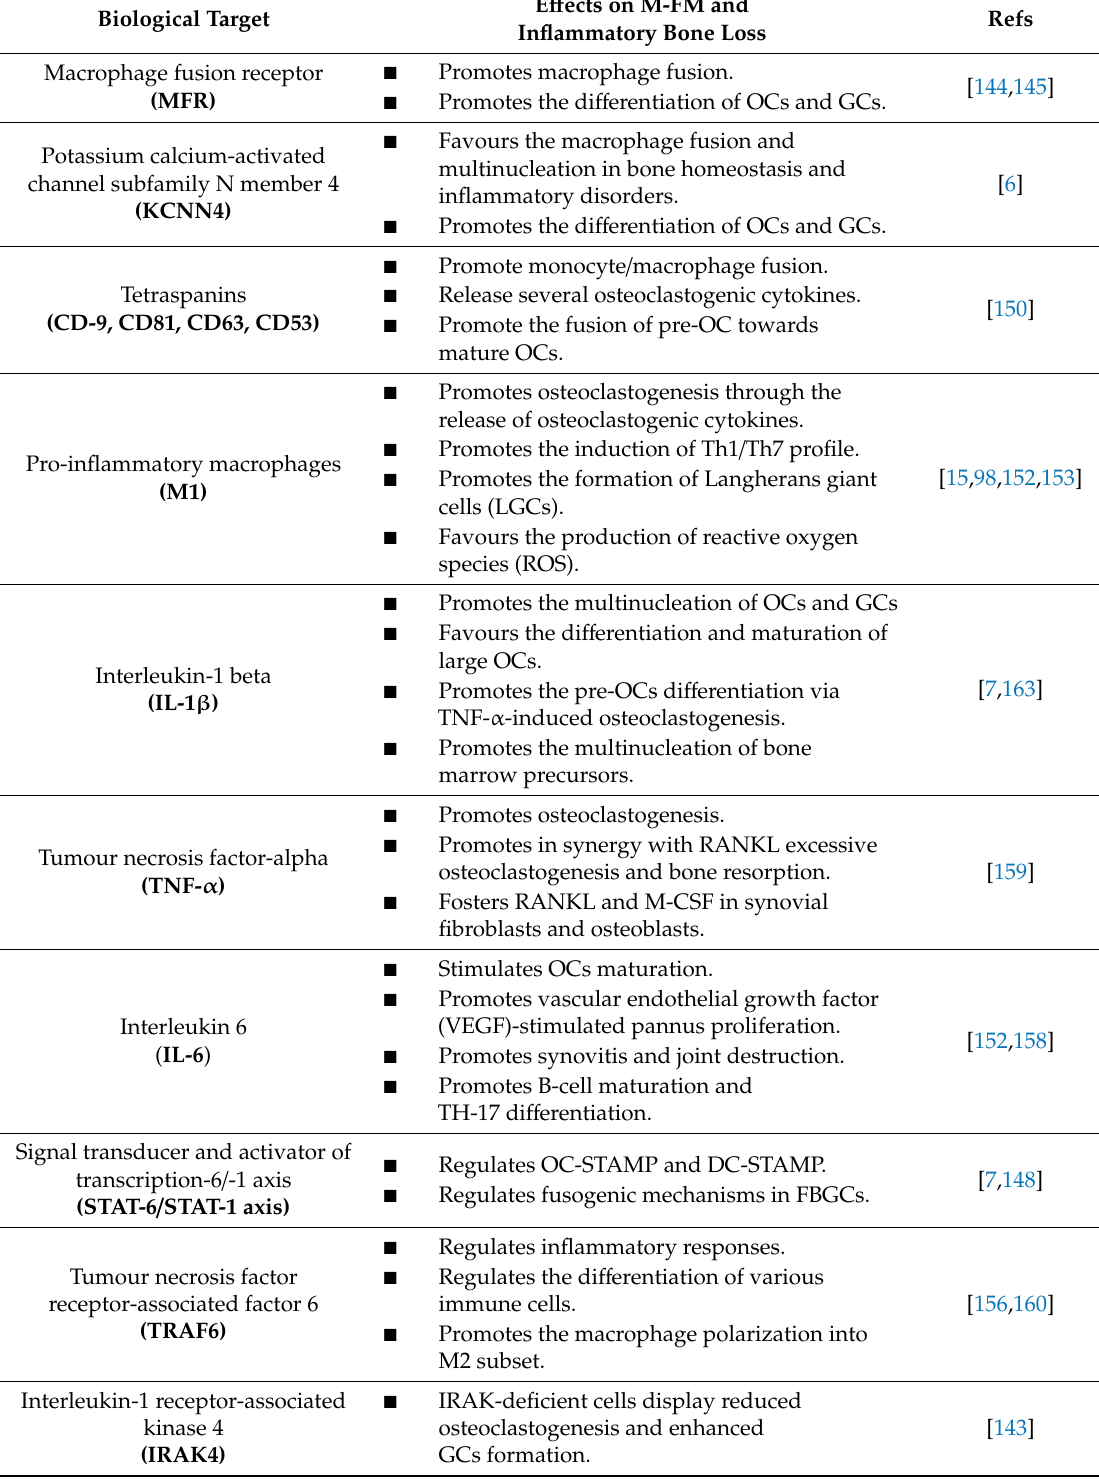
Table 3. Biological targets involved in monocyte-macrophages fusion and multinucleation (M-FM) during the inflammatory bone